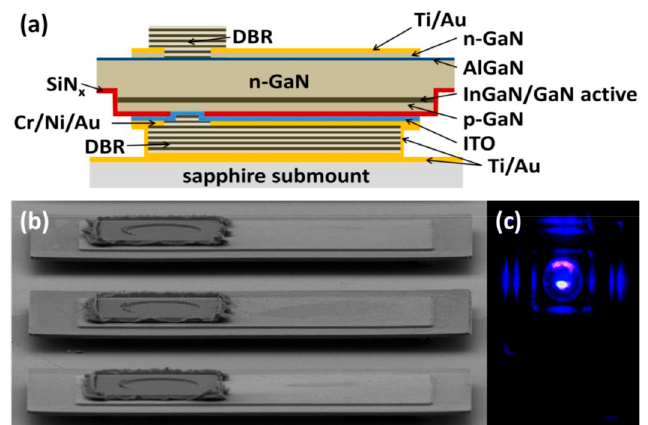
Figure 8. ( a ) Cross-sectional schematic of nonpolar m-plane GaN VCSEL with flip-chip design and dielectric mirrors. ( b ) Scannng electron microscope (SEM) image of multiple completed devices. ( c ) Optical microscopy image of device lasing under pulsed operation [84]. Copyright 2012 Appl. Phys. Express.